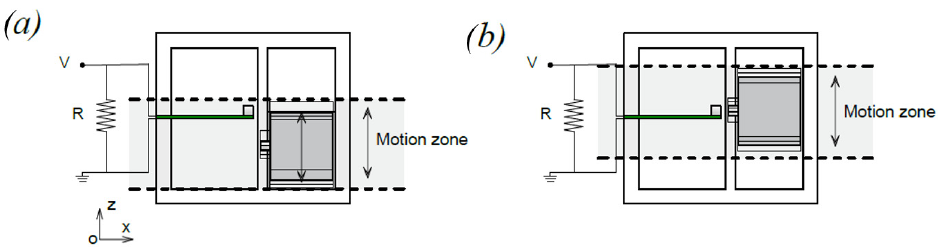
Figure 18. Working cycles in the case of low-level input acceleration (such as for the running activity): ( a ) repulsive interaction; ( b ) attractive interaction.